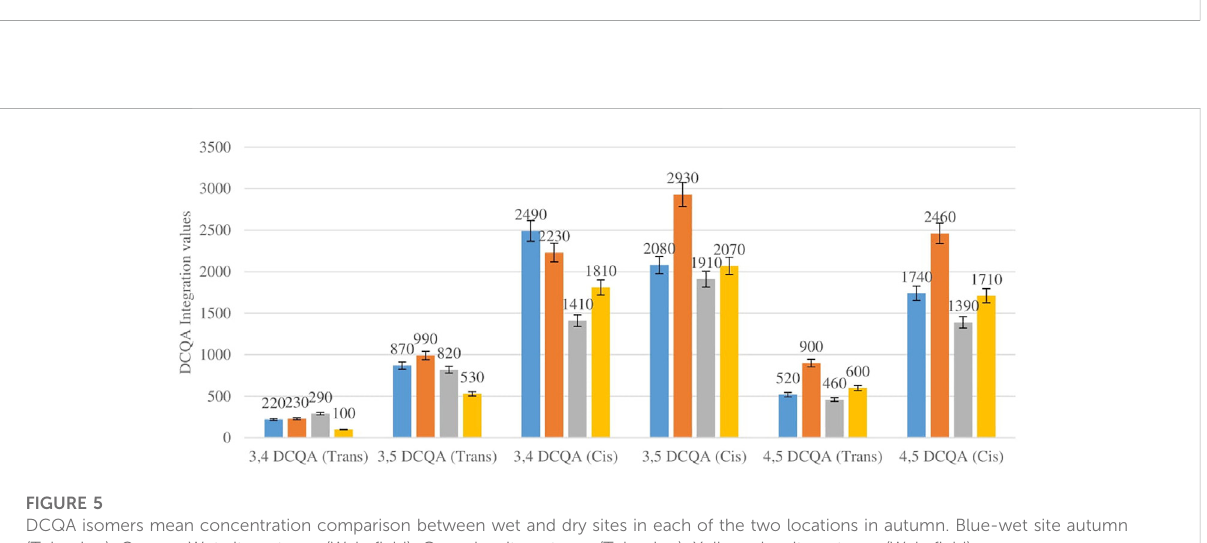
FIGURE 4 CQA isomers mean concentration comparison between wet and dry sites in each of the two locations in autumn. Blue-wet site autumn (Telperion), Orange-wet site autumn (Wake fi eld), Grey-dry site autumn (Telperion), Yellow-dry site autumn (Wake fi eld).